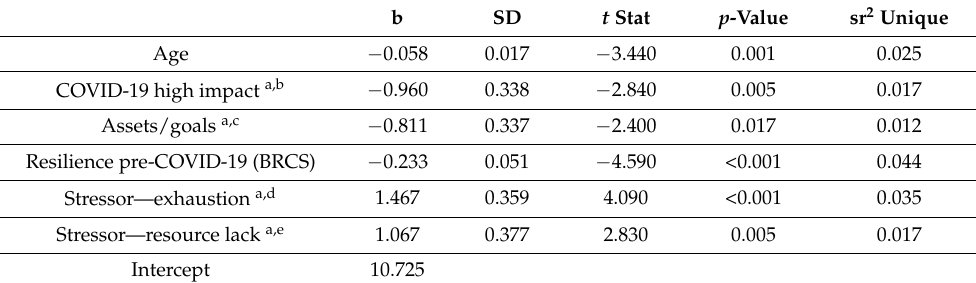
Table 6. Variables associated with burnout during COVID-19 (multiple regression).